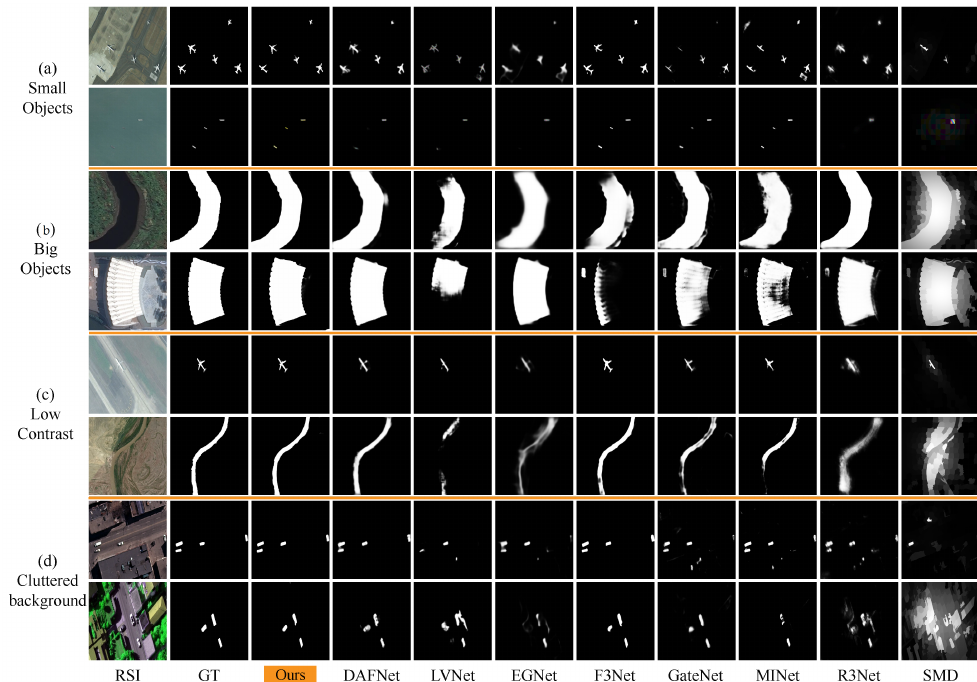
Figure 8. Visual comparison between our results and SOTA methods in various challenging RSI scenes, including scenes with small ( a ) and big ( b ) objects, scenes with low contrast ( c ), and cluttered backgrounds ( d ), better for zooming in. Our SARNet under the ResNet50 backbone and deep learning based methods are trained or retrained on the EORSSD